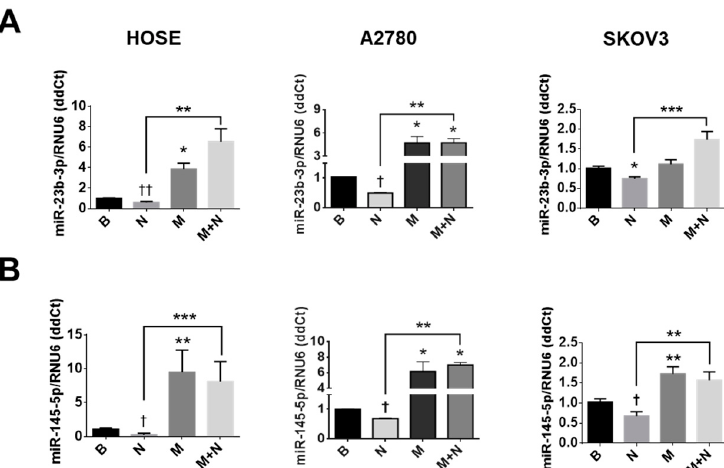
Figure 5. Metformin increases the expression of miR-145 and miR-23b in ovarian cell lines. Ovarian cells were treated with metformin (10 mM for 48 h) and NGF (100 or 150 ng / mL, last 3 h) to detect miR expression. miR-23b and miR-145 were quantified in HOSE, A2780 or SKOV3 cells by qPCR. N = 4 or more independent experiments in duplicate. * p < 0.05; ** p < 0.01 and *** p < 0.001 as indicated or with respect to basal conditions. Statistical analysis: Kruskal–Wallis and Dunn´s post-test. † p < 0.05 and †† p < 0.01 with respect to basal conditions or where indicated using the Mann–Whitney test. B: basal condition (without stimuli), N: NGF, M: metformin treatment. Results are expressed as the mean ± standard error of the mean (SEM).